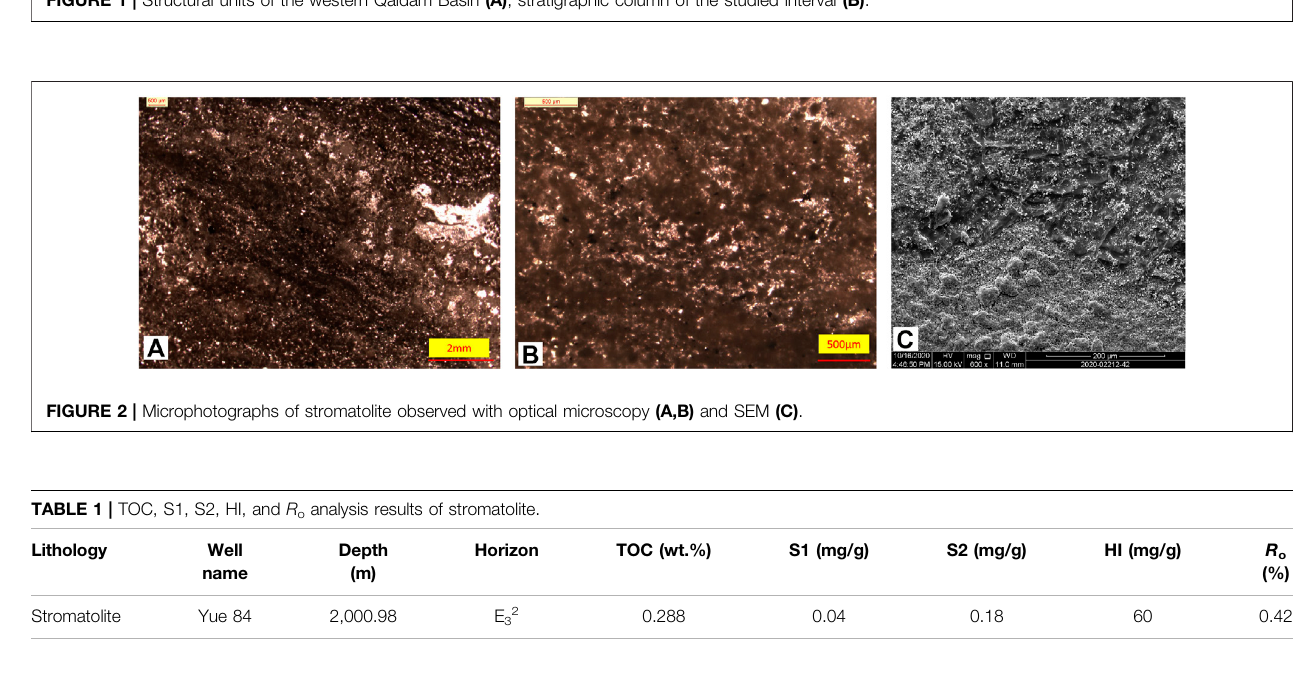
FIGURE 1 | Structural units of the western Qaidam Basin (A) , stratigraphic column of the studied interval (B) .